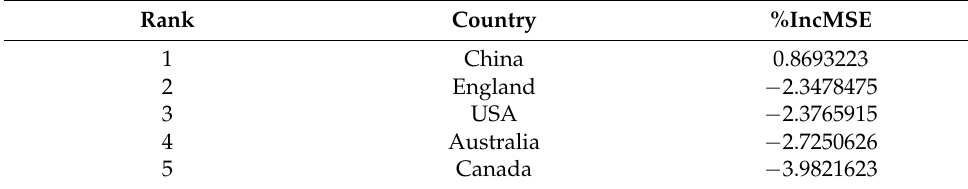
Table 11. Impactors’ rank